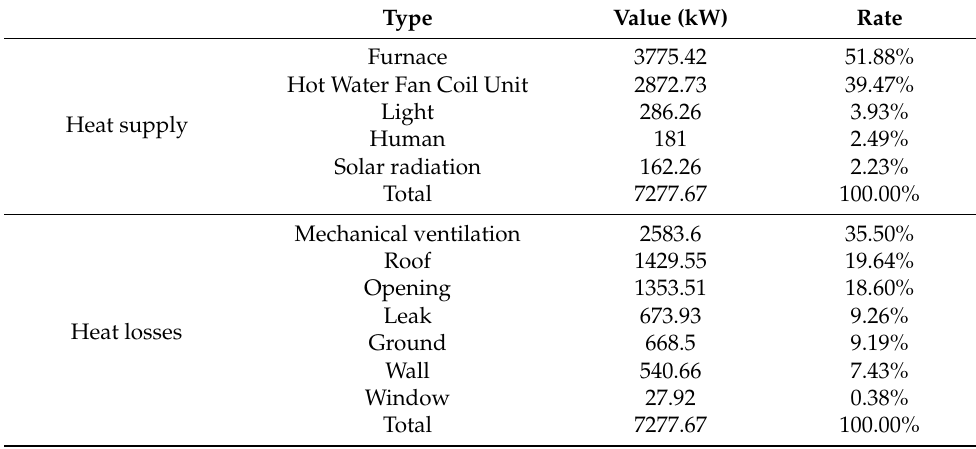
Table 6. Heat supply and losses with results of building energy